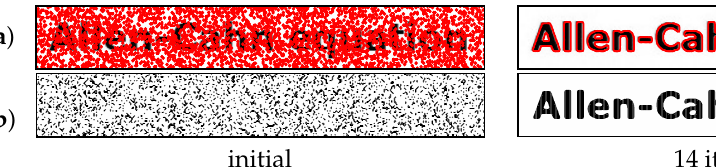
Figure 8. Allen–Cahn equation text image segmentation with a random initial condition. ( a ) Original image and contour line. ( b ) Filled contours.